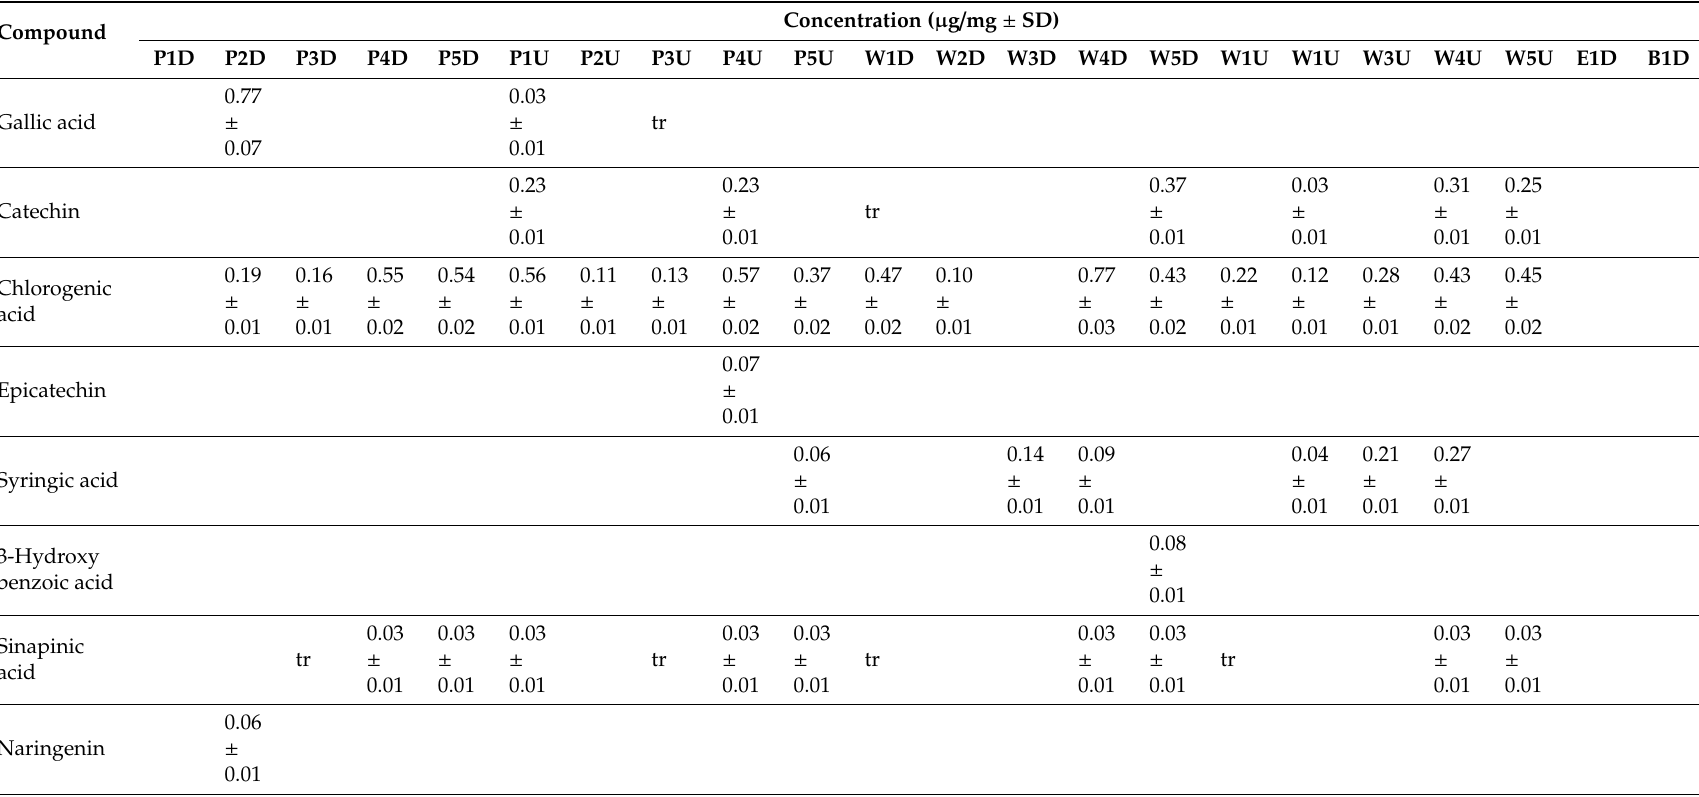
Table 1. Phenolic pattern of goji